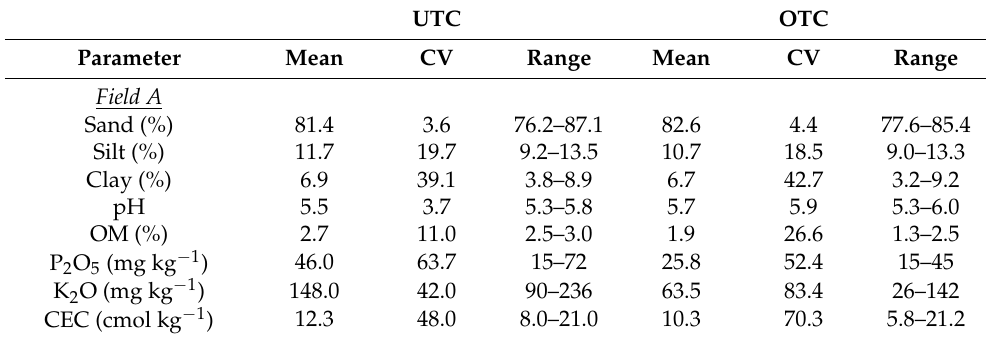
Table 2. Descriptive statistics (mean, coefficient of variation and range) of the soil parameters (0–0.30 m depth) in each of the two experimental fields (A and B) used in this